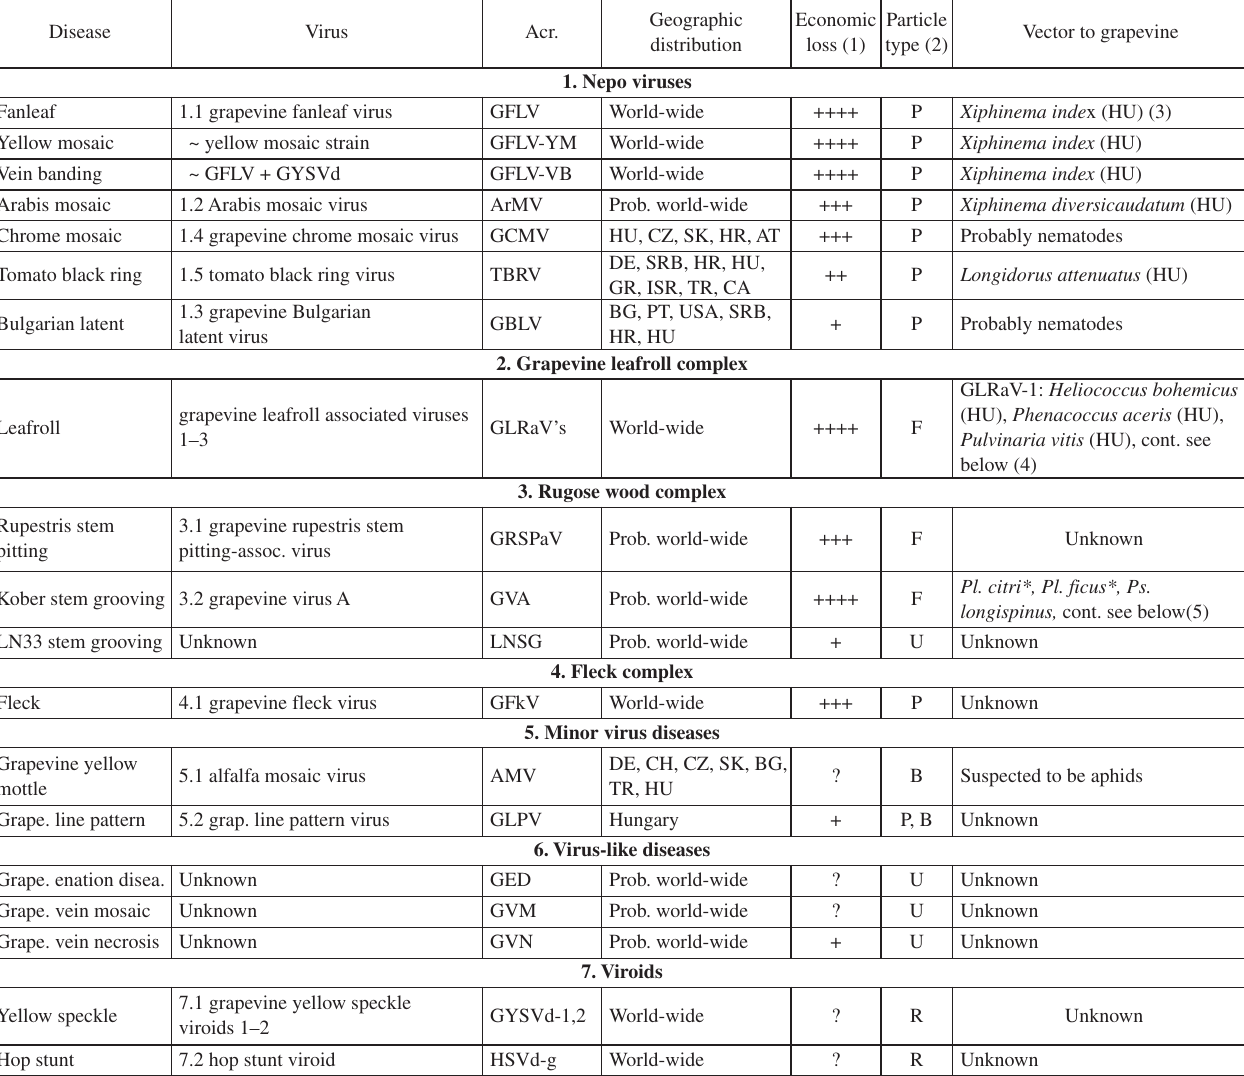
Table 2. Grapevine viruses, virus-like diseases of grapevines in Hungary. Some properties and